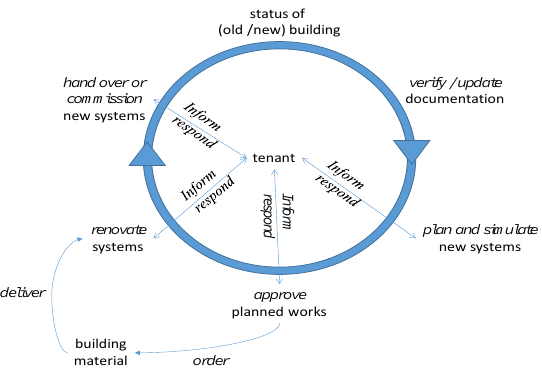
Figure 6 - Renovation activities covered in